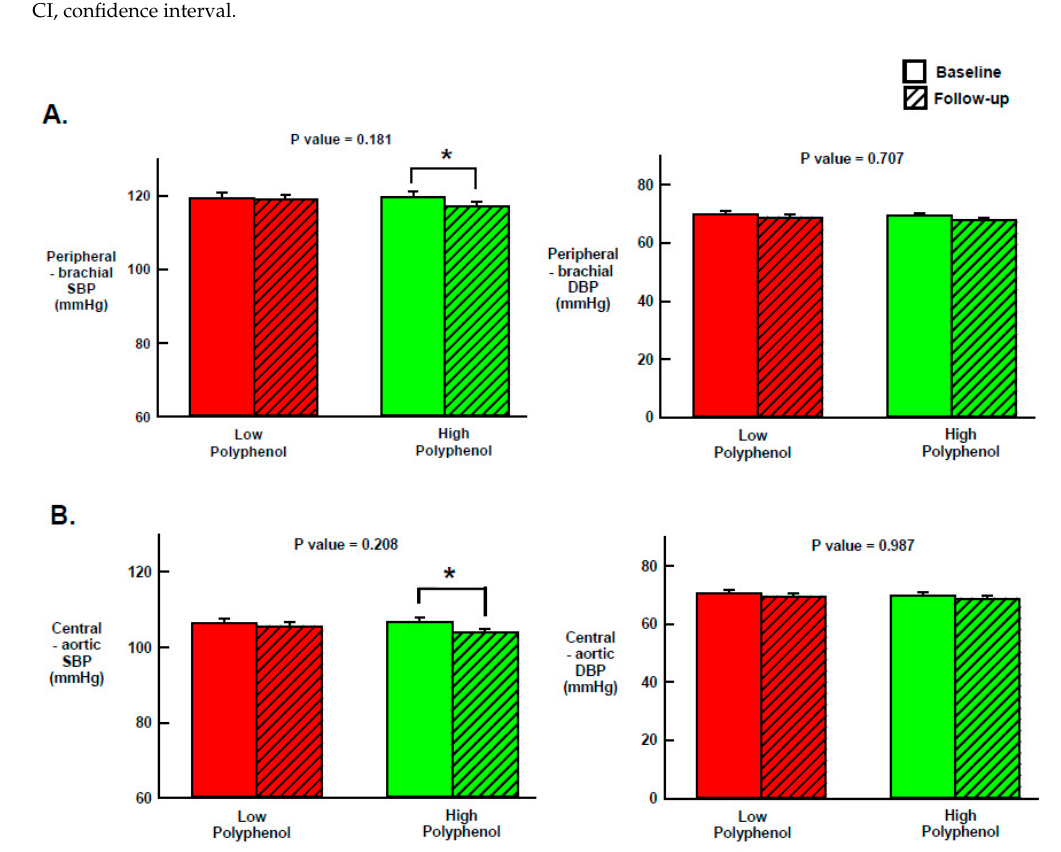
Figure 2. E ff ect of 3-weeks daily consumption of extra virgin high polyphenol olive oil (HPOO; 360 mg / kg polyphenols) and low polyphenol OO (LPOO; 86 mg / kg polyphenols) on mean peripheral ( A ) and central ( B ) blood pressure. N = 50 participants. SBP, systolic blood pressure; DBP, diastolic blood pressure. Data are mean ± standard deviation. The P values in the Figure indicate the between-group di ff erences in the changes from baseline to follow-up (treatment*time e ff ect) for each blood pressure measure. The asterisk (*) indicates significance ( p < 0.05) of within-group changes from baseline to follow-up.